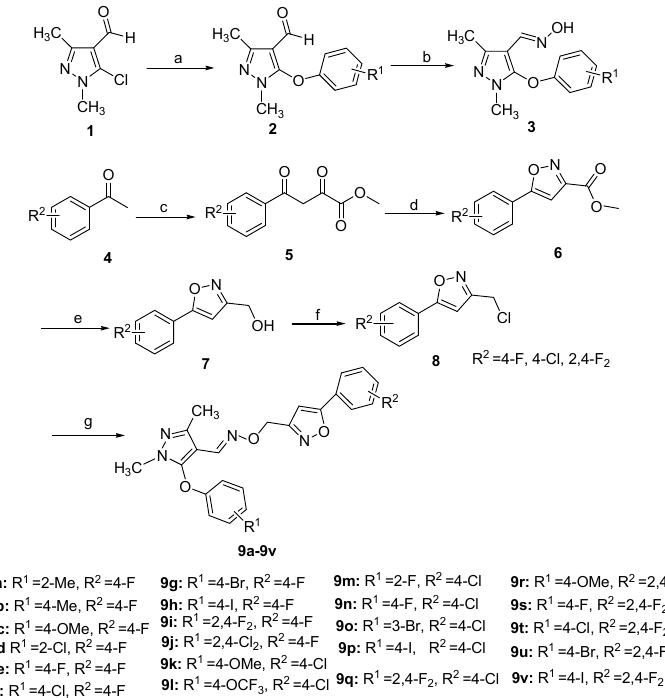
9a: R 1 =2-Me, R 2 =4-F 9b: R 1 =4-Me, R 2